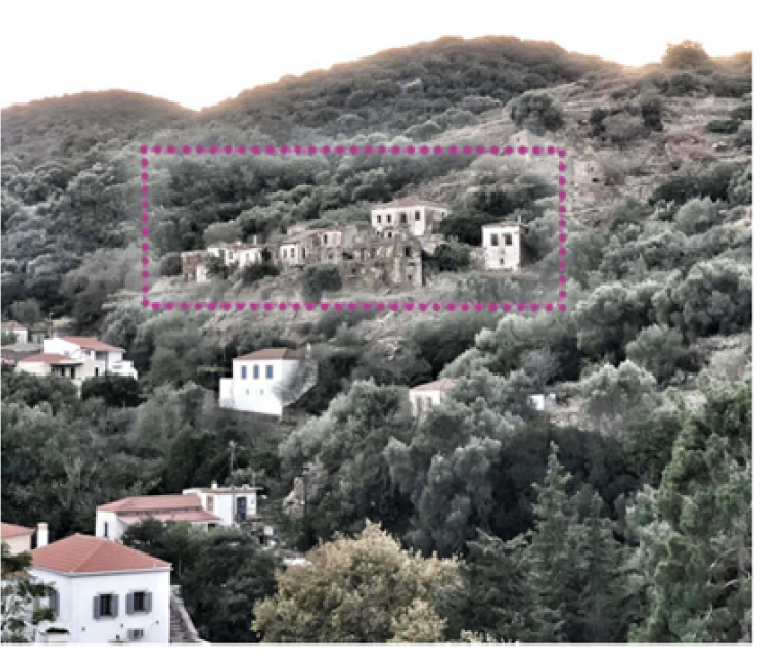
Figure 27. Mavrogiorgiannika in Karavas.